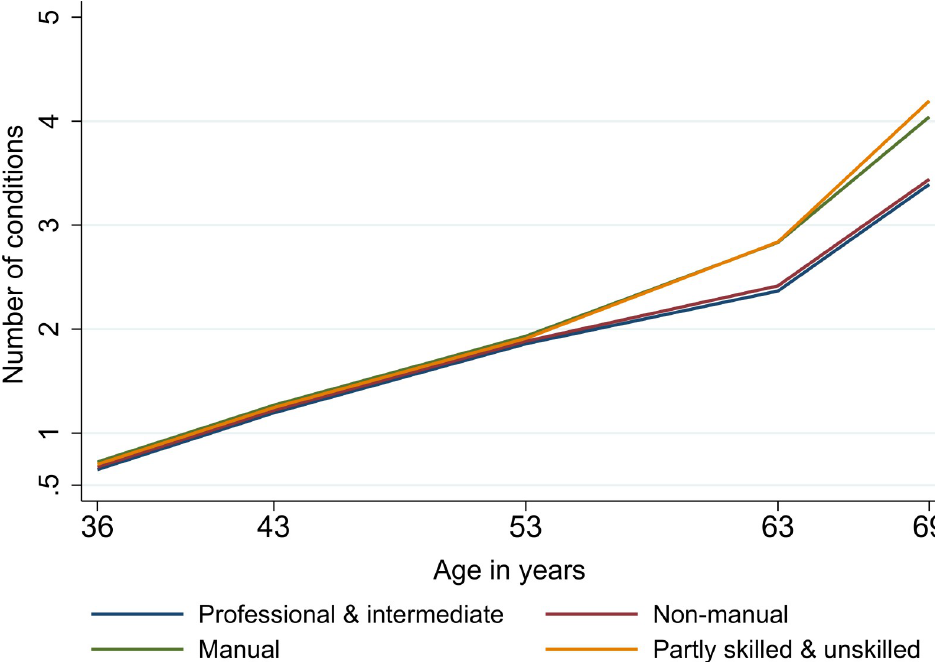
Fig 5. Socioeconomic inequalities in multimorbidity trajectories by childhood social class in 3,723 participants from the 1946 MRC NSHD. Note: Fig 5 is based on Model 2 in Table G and adjusted for sex, adulthood social class, and educational level. NSHD, National Survey of Health and